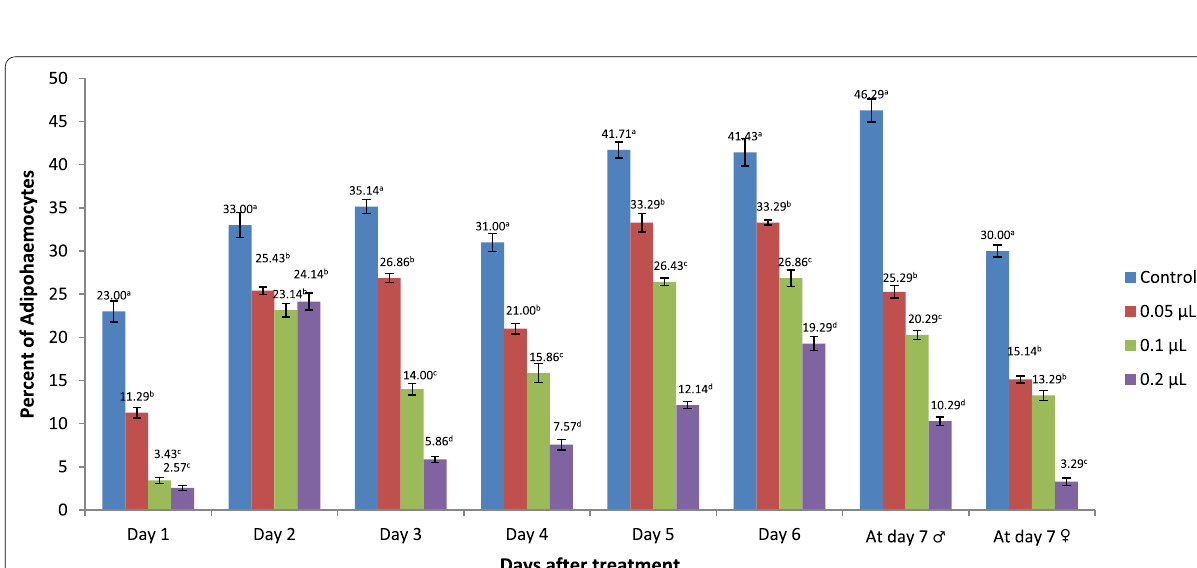
Fig. 3 Effect of Farnesol on Plasmatocytes of fifth instar nymphs of Dysdercus koenigii. Each bar represents Mean for calculation of mean Bars on a specific day after treatment with different letter are significantly different ( p < 0.05), computed by one-way ANOVA followed by Tukey’s all pairwise multiple comparison test